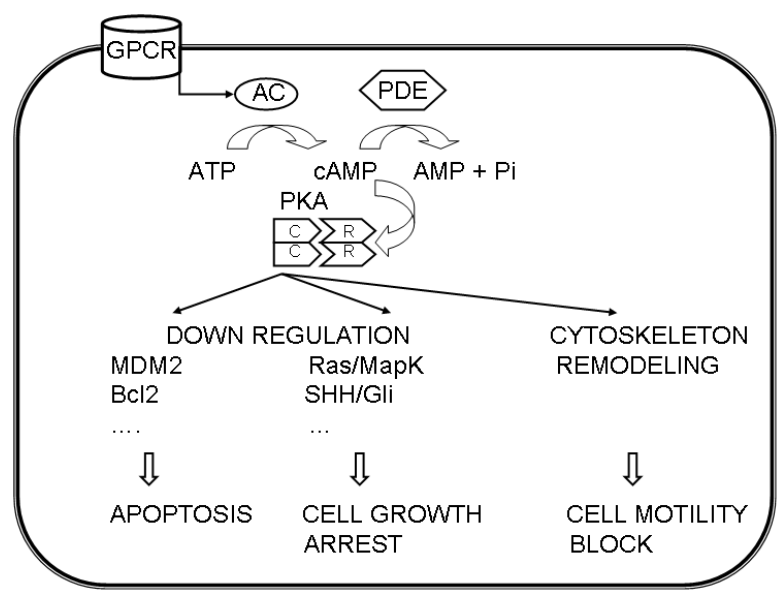
Figure 1. A simplified scheme of the possible involvement of cAMP/PKA pathway in cancer. Adenylyl cyclase (AC) may be activated in several ways, including G-protein-coupled receptors (GPCR), leading to the formation of cAMP, that binds to the regulatory (R) subunits of PKA, thus releasing the catalytic subunits (C). In turn, these phosphorylate several target proteins, leading to apoptosis, arrest of cell growth and block of the cell